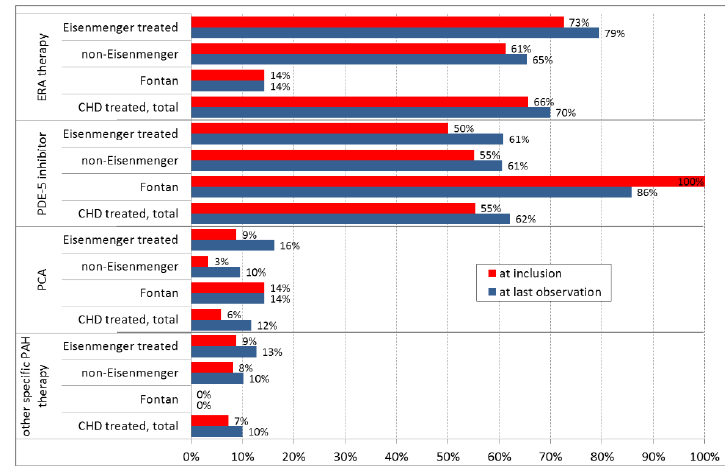
Figure 2. Drug classes for targeted PAH therapy in the patients with CHD-associated PAH at inclusion and at last observation (mean/median observation time of 50.5/45.3 months respectively; for 512 patients with at least one follow-up). “Other therapy” includes soluble guanylate cyclase (sGC) stimulator, tyrosine kinase inhibitor, calcium channel blockers, and other PAH-specific trial therapies. Abbreviations: PCA, prostanoids.